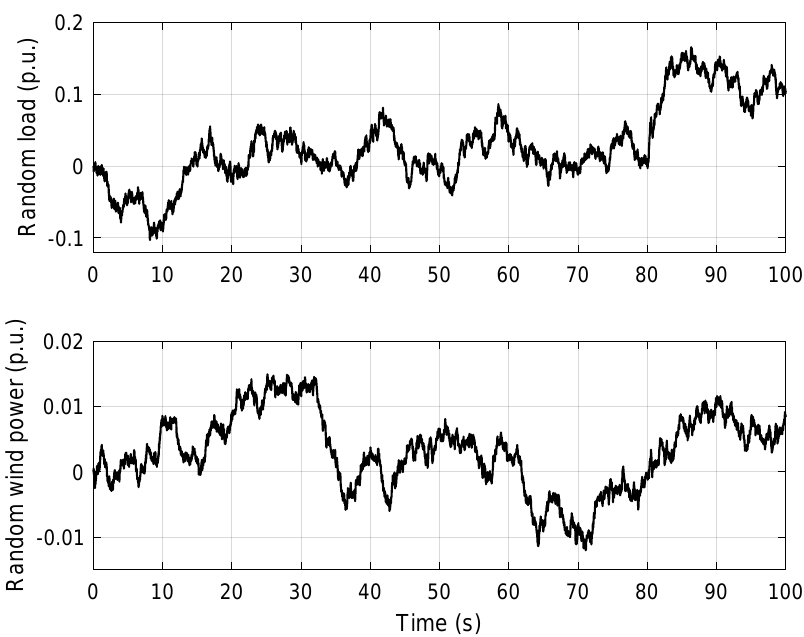
Figure 7. The profile of random variations in the wind and load powers based on